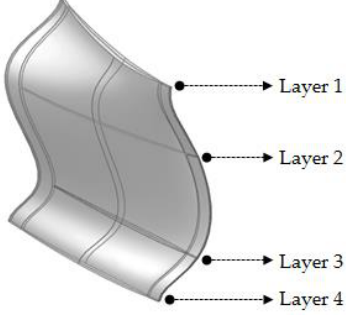
Figure 6. Layer definition of the plenum fan blade.